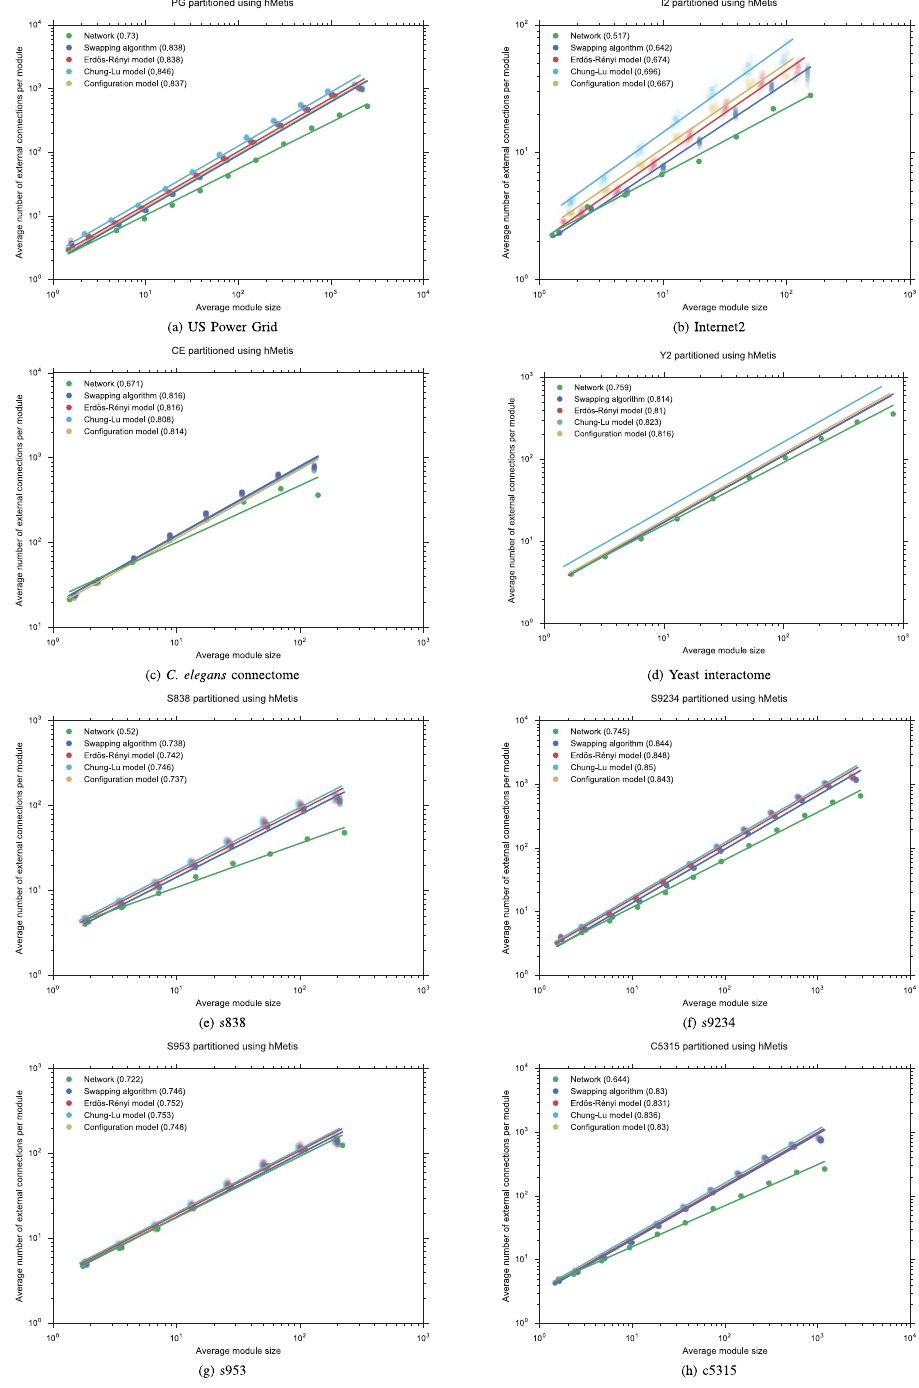
Figure 3. Recursive bipartitioning is applied to obtain the Rent characteristics of each empirical network and each random network (SA), (CM), (CLM) and (ER) with the same order and